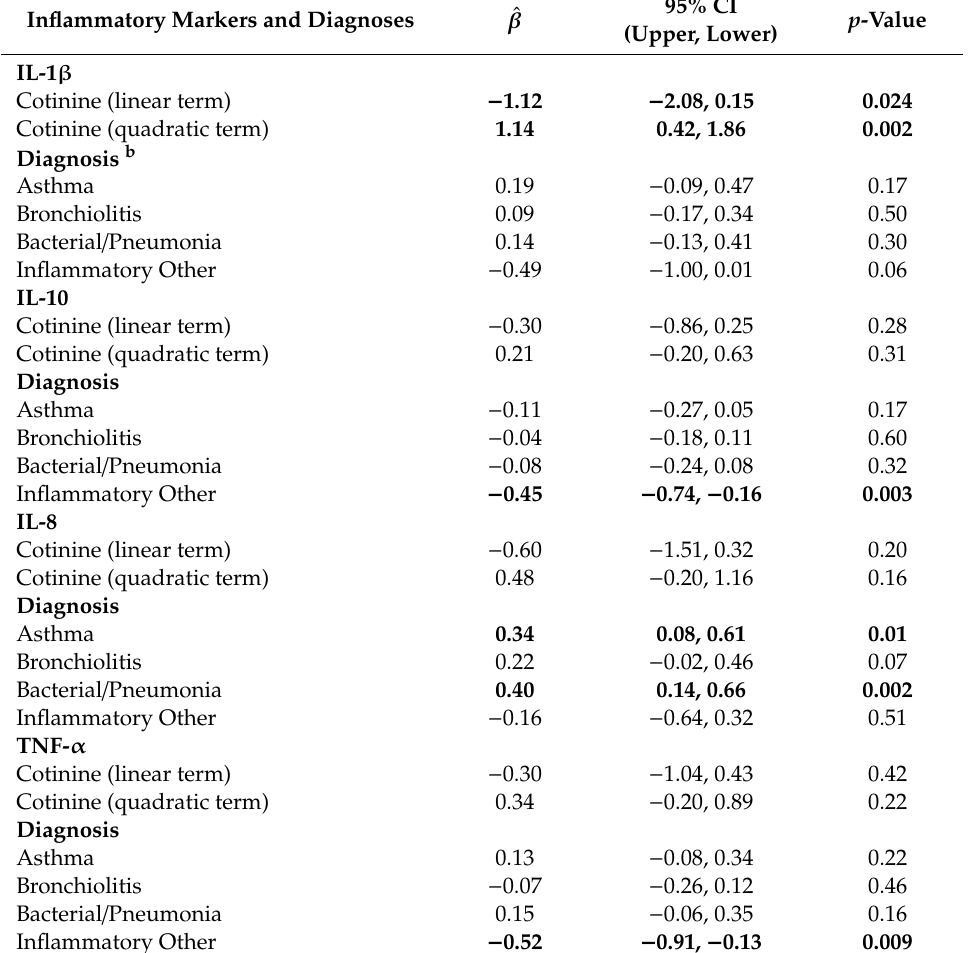
Table 2. Multivariate regression model results assessing the relationship between cotinine and inflammatory markers a